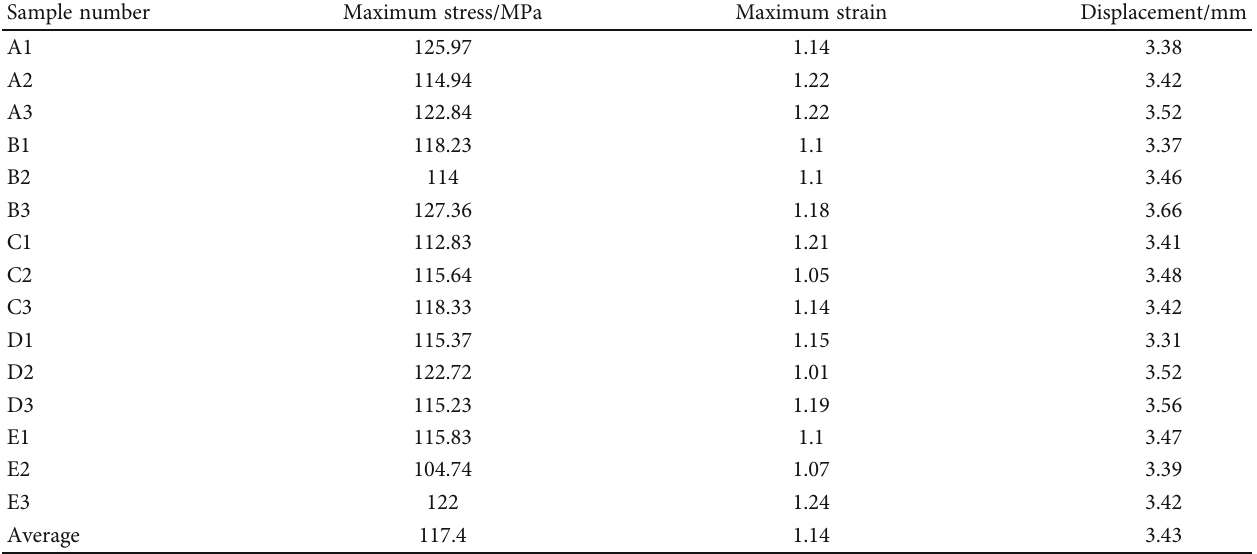
Table 4: Experimental data of 70 mm span.